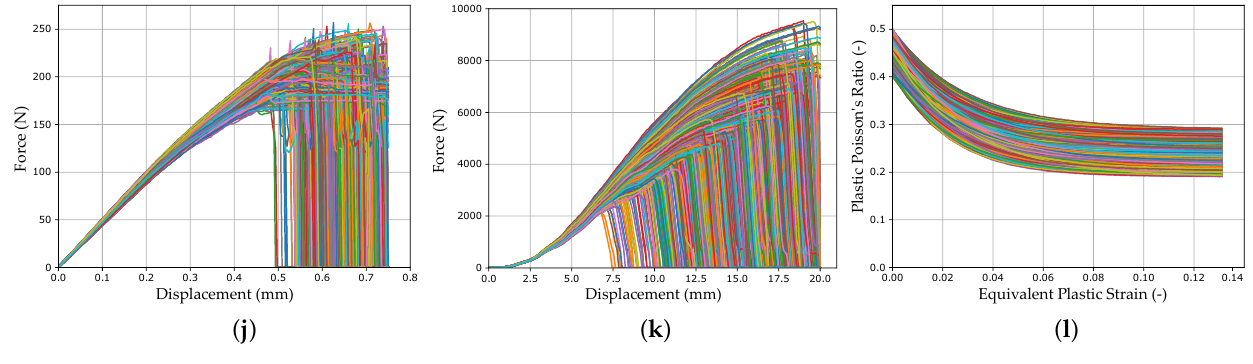
Figure A6. Simulated output curves of the tests for training data of dataset 2: ( a ) FDC tension test; ( b ) FDC compression test; ( c ) PEC compression test; ( d ) FDC tension tests V1; ( e ) FDC tension tests V2; ( f ) FDC tension tests V3; ( g ) FDC tension tests V4; ( h ) FDC bending test; ( i ) FDC shear1 test; ( j ) FDC shear2 test; ( k ) FDC punch test; and ( l ) PEC punch test.